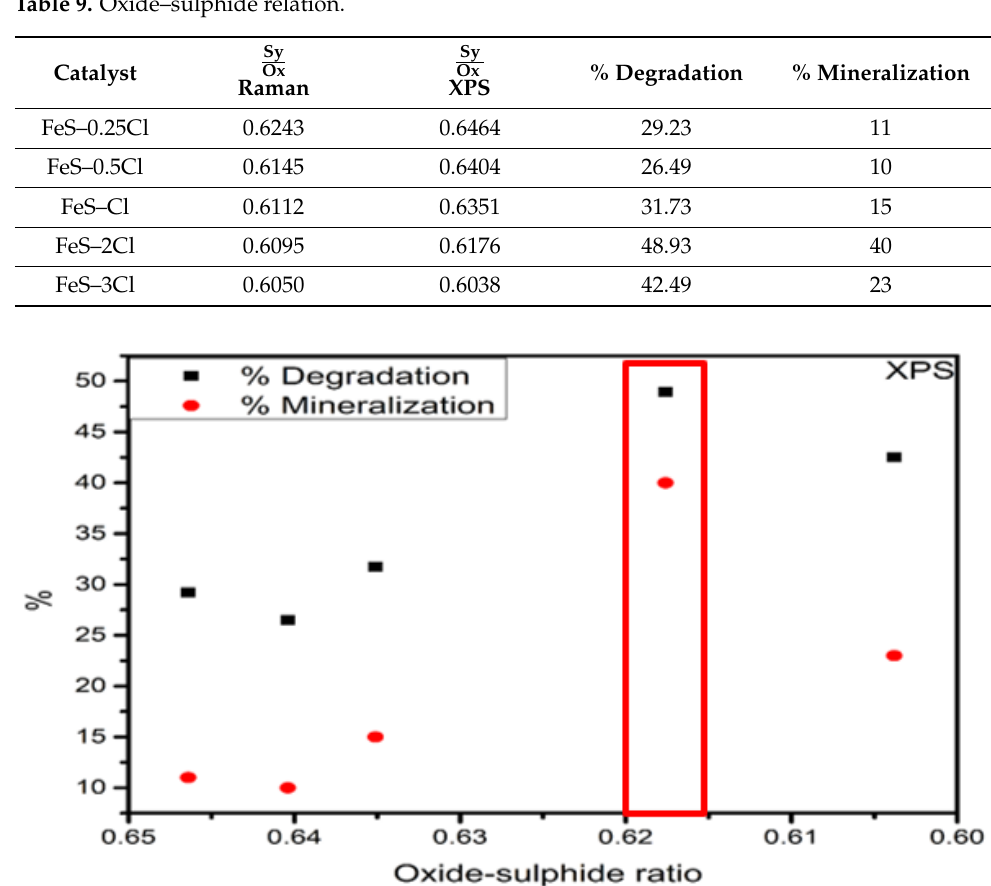
Table 10. S/Fe ratio.